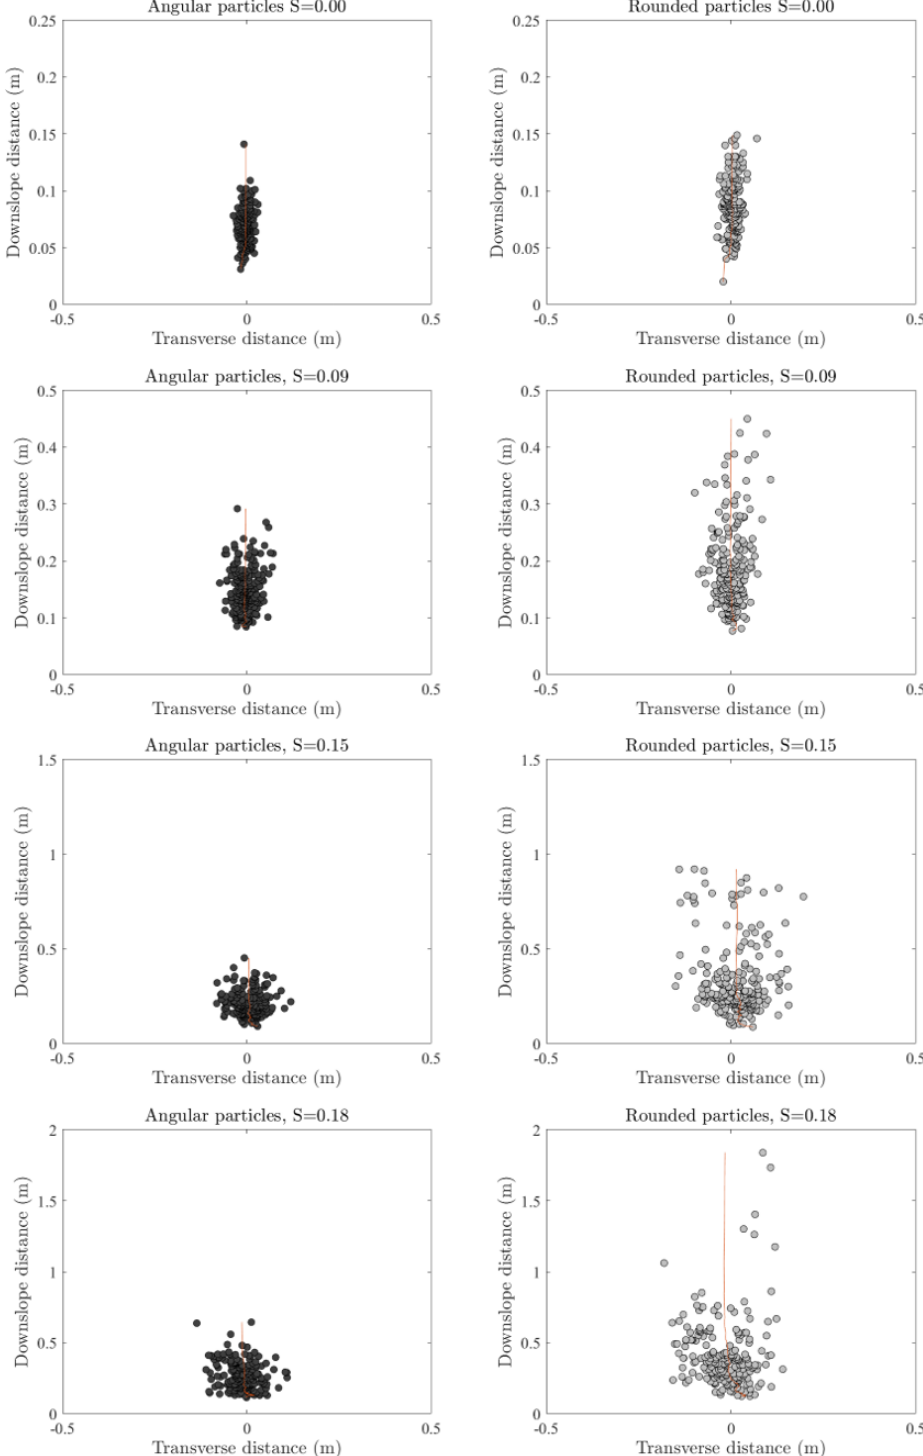
Figure 11. Scatter plots of final resting positions of angular (dark gray) and rounded (medium gray) particles on slopes S = 0 . 00 to S = 0 . 18. Cumulative mean transverse positions are indicated in red. Rounded particles disperse further downslope and transversely compared to angular particles. Deposition locations do not indicate late stage spreading like one would expect from Galton board-like behavior.